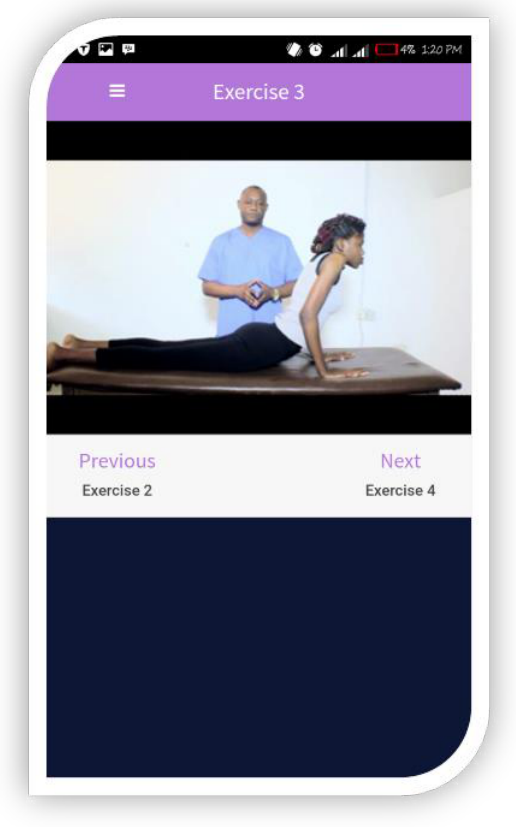
Figure 4. McKenzie extension exercise 2. Figure 5. McKenzie extension exercise